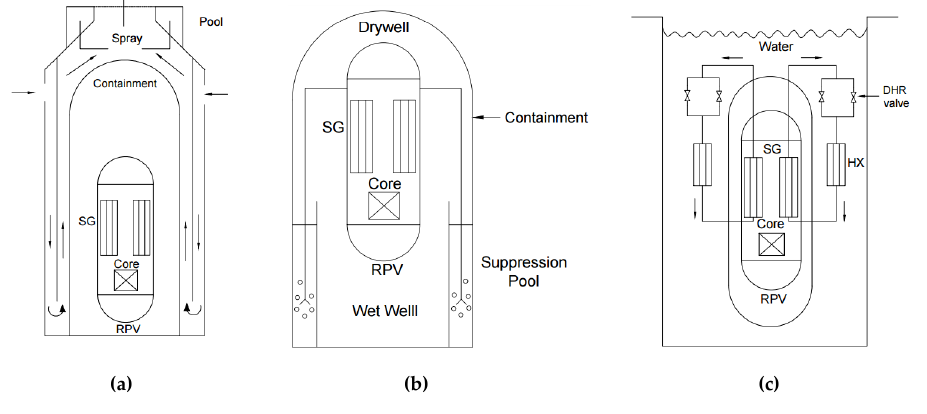
Figure 5. ( a ) Air cooled, ( b ) suppresion type, ( c ) pool type.